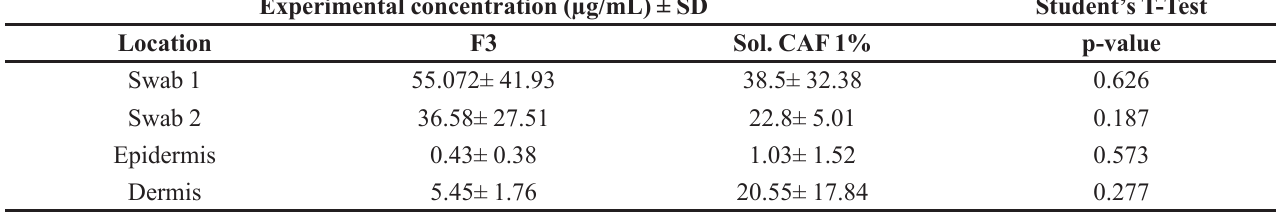
TABLE III - In vitro permeation profile in human skin of nanoemulsion with caffeine 1% w/v and caffeine solution in water (1% w/v) after 24 h